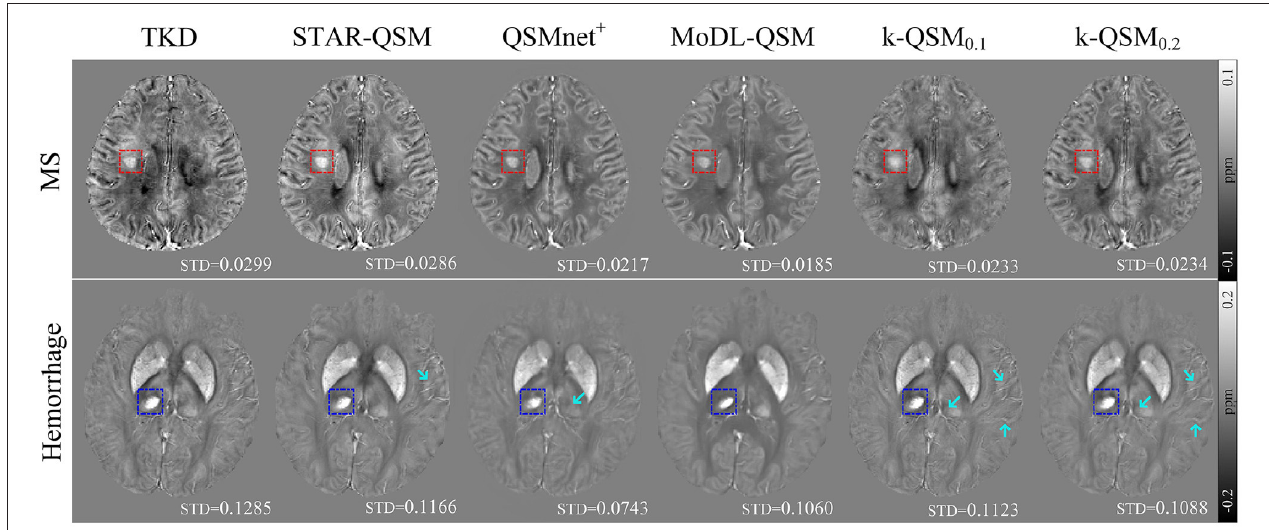
FIGURE 8 | Axial views of quantitative susceptibility mapping (QSM) reconstructed using truncated k-space division (TKD) (thr = 0.2), STAR-QSM, QSMnet + , MoDL-QSM, and k-QSM on patients with MS (red boxes) and hemorrhage (blue boxes), and standard deviation (STD) values of the corresponding boxes are reported below. Cyan arrows mark richer details in the results of k-QSM and